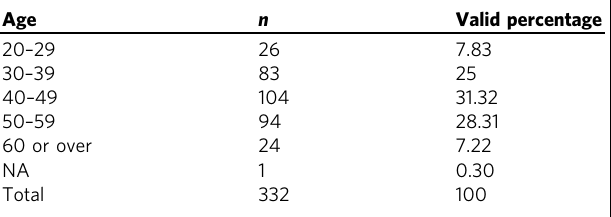
Table 1 Age intervals of the